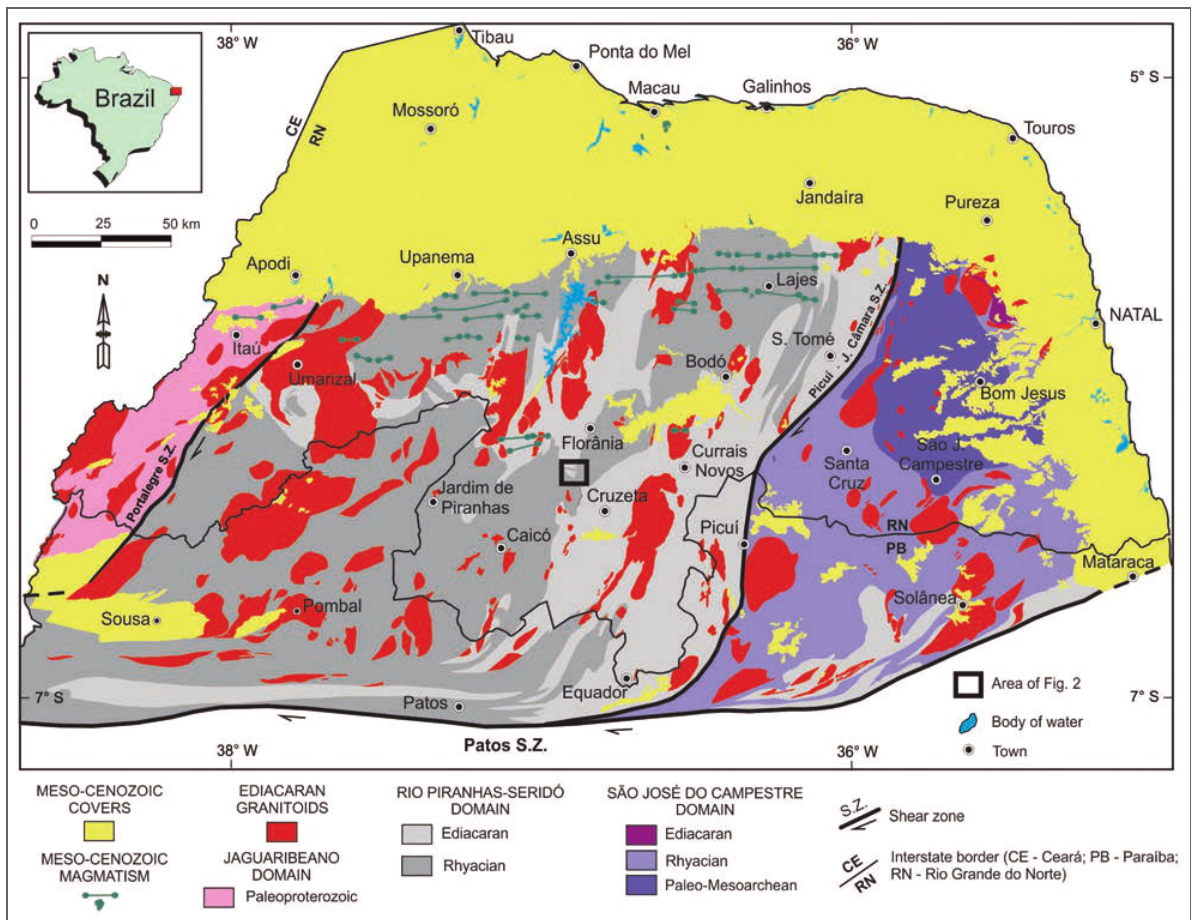
Figure 1 - Geological framework of northeastern Borborema Province showing the studied area. Modified from Medeiros et al.